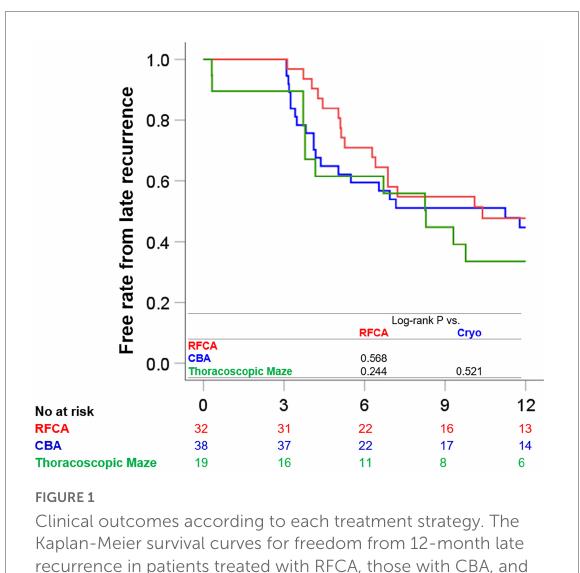
FIGURE1 Clinical outcomes according to each treatment strategy. The Kaplan-Meier survival curves for freedom from 12-month late recurrence in patients treated with RFCA, those with CBA, and those treated with thoracoscopic maze surgery are presented. CBA, cryoballoon ablation; RFCA, radiofrequency catheter ablation.